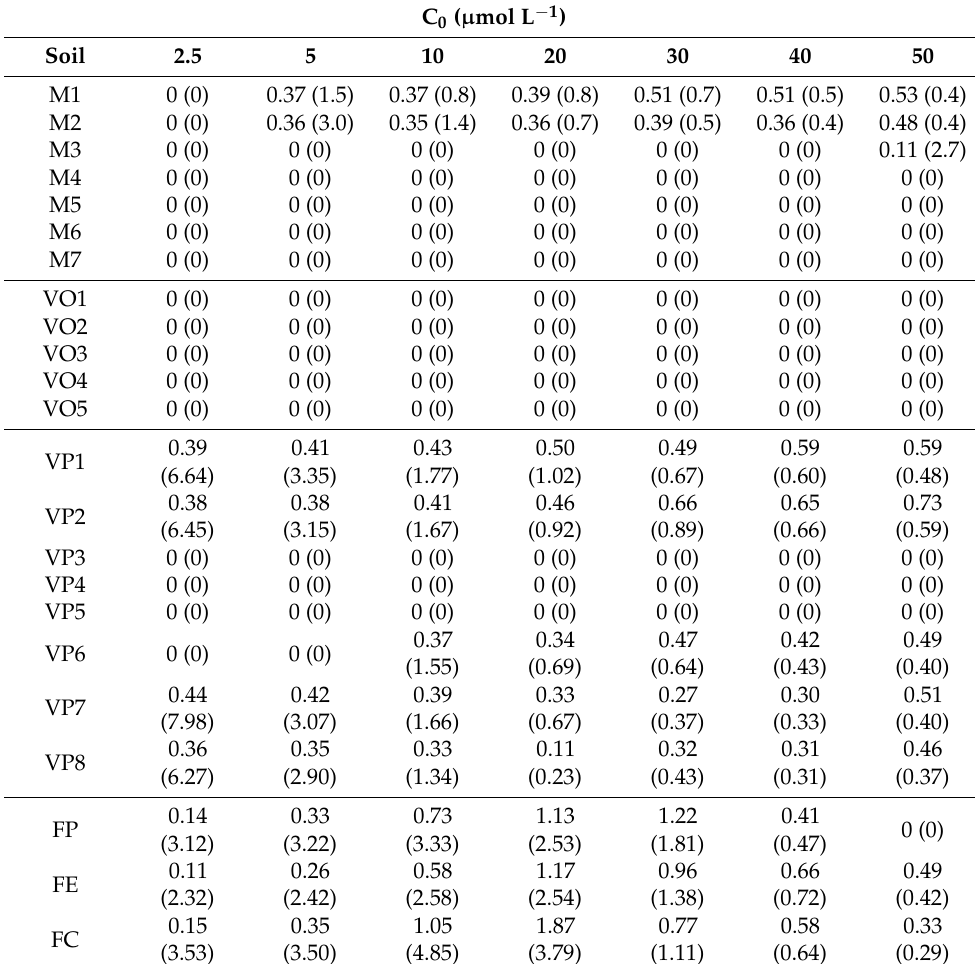
Table 2. CFX desorption, expressed in µ mol kg − 1 (and in a percentage, between brackets), from the various studied soils, as a function of the concentration of antibiotic added (C 0 , in µ mol L − 1 ). M, maize (corn) soils; VO, vineyard soils (Ourense province); VP, vineyard soils (Pontevedra province); F, forest soils. Average values ( n = 3), with coefficients of variation always <